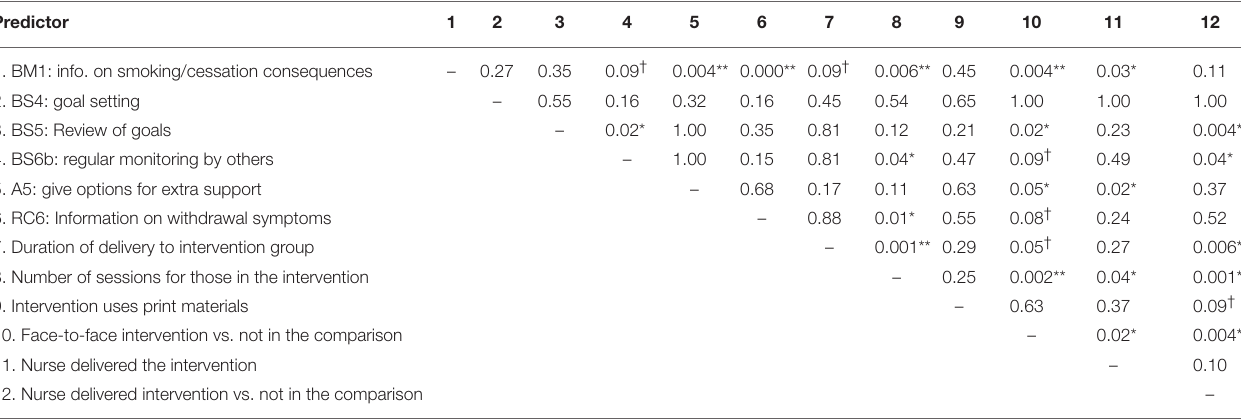
TABLE 6 | Significance of associations ( p -values) between predictors of smoking cessation effect sizes.